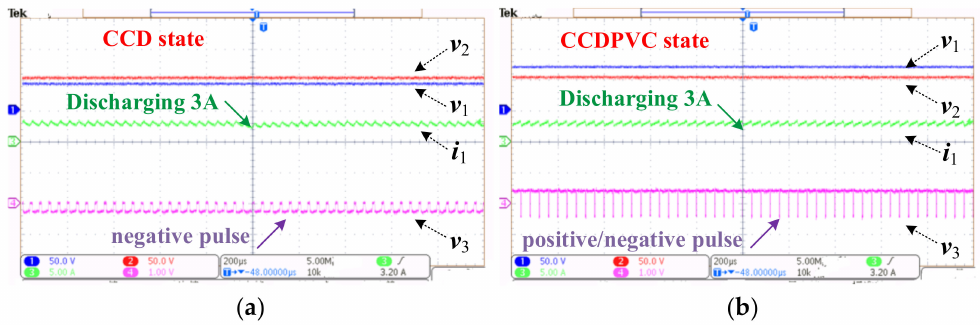
Figure 14. Waveforms during discharging process: ( a ) CCD state; and ( b ) CCD-PVC